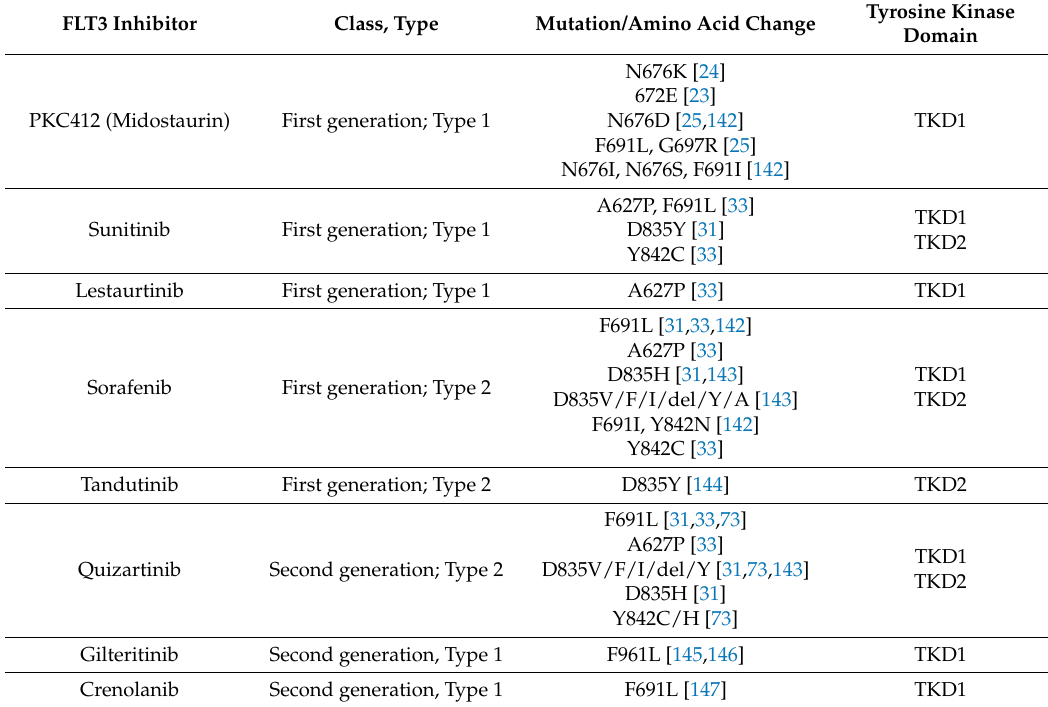
Table 1. Mutations associated with resistance to FLT3